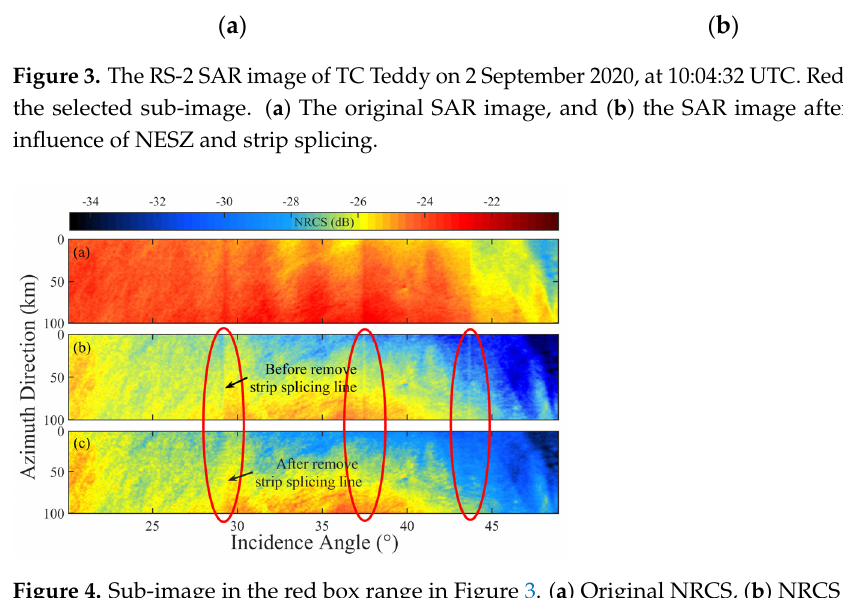
Figure 4. Sub-image in the red box range in Figure 3. ( a ) Original NRCS, ( b ) NRCS after removing the NESZ, and ( c ) NRCS after removing the NESZ and strip splicing.